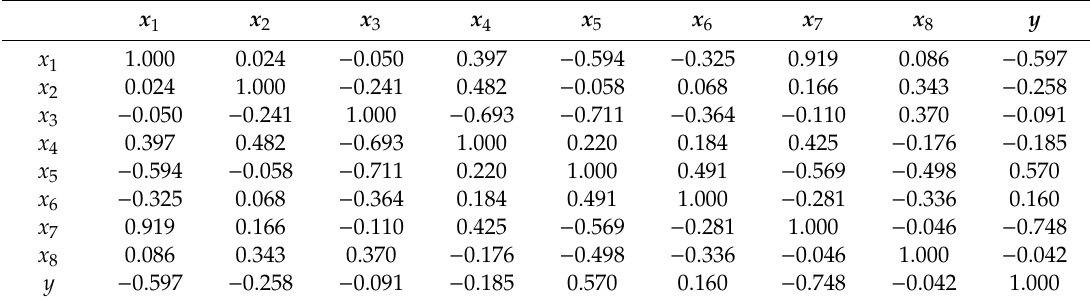
Figure 8. Principal component score plot of the eight predictor variables in the free swelling index system ( left ) and a scatterplot of the most important variables ( right ). The colors imposed on the markers show the corresponding values of the free swelling index, as indicated by the color bar. Table 2. Correlation coefficient matrix of the predictors and response variable in the coal data set.